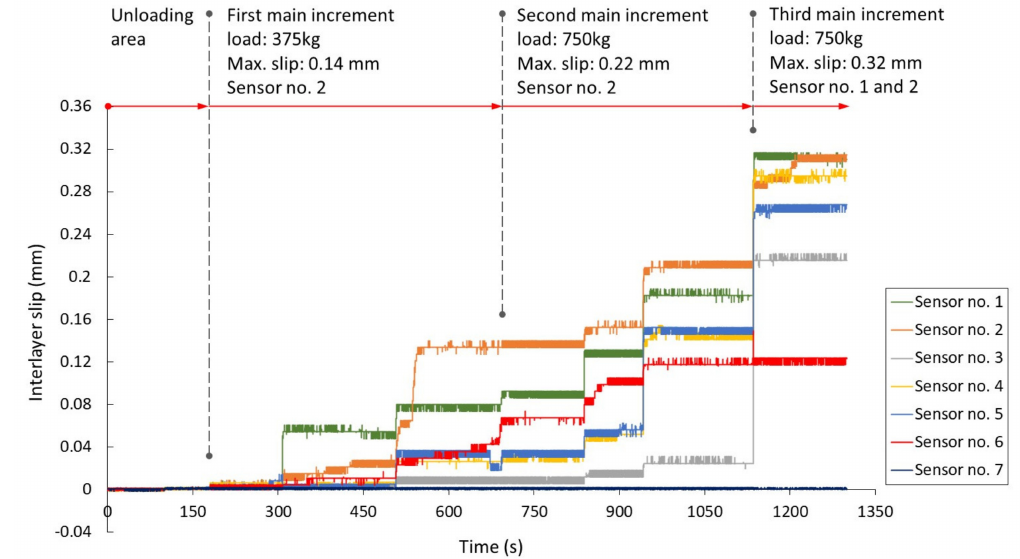
Figure 14. The interlayer slip of composite beam for double damage (second and fifth rows of bolts from right hand side are